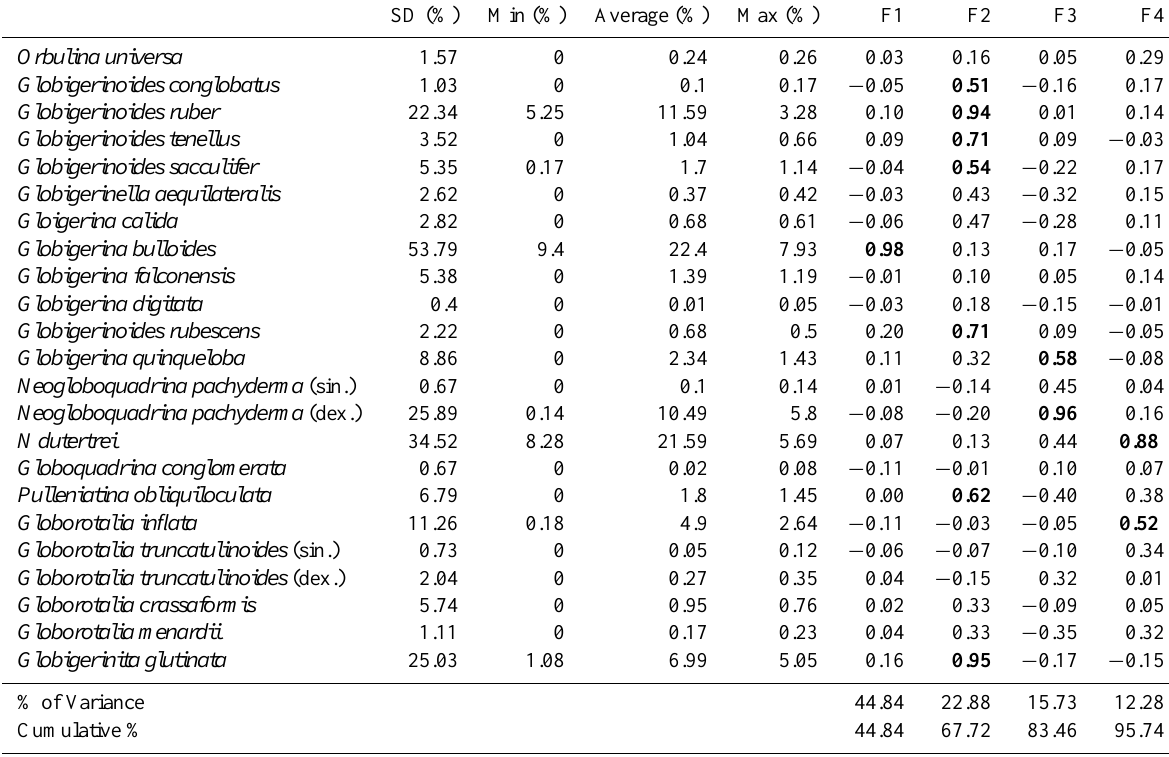
Table 2. Descriptive statistics of planktonic foraminiferal species and Q-mode varimax factor analysis for core CSH1.